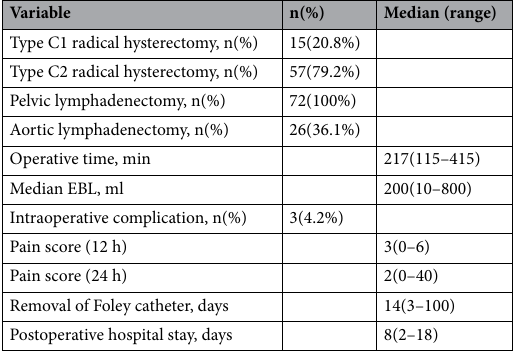
Table 2. Intra- and postoperative details(no. of surgery = 72). SPSS 17.0 (IBM Corp, Armonk, NY, USA) was used for statistical analysis.The website of SPSS is https:// www. ibm. com/ cn- zh/ analy tics/ spss- stati stics- softw